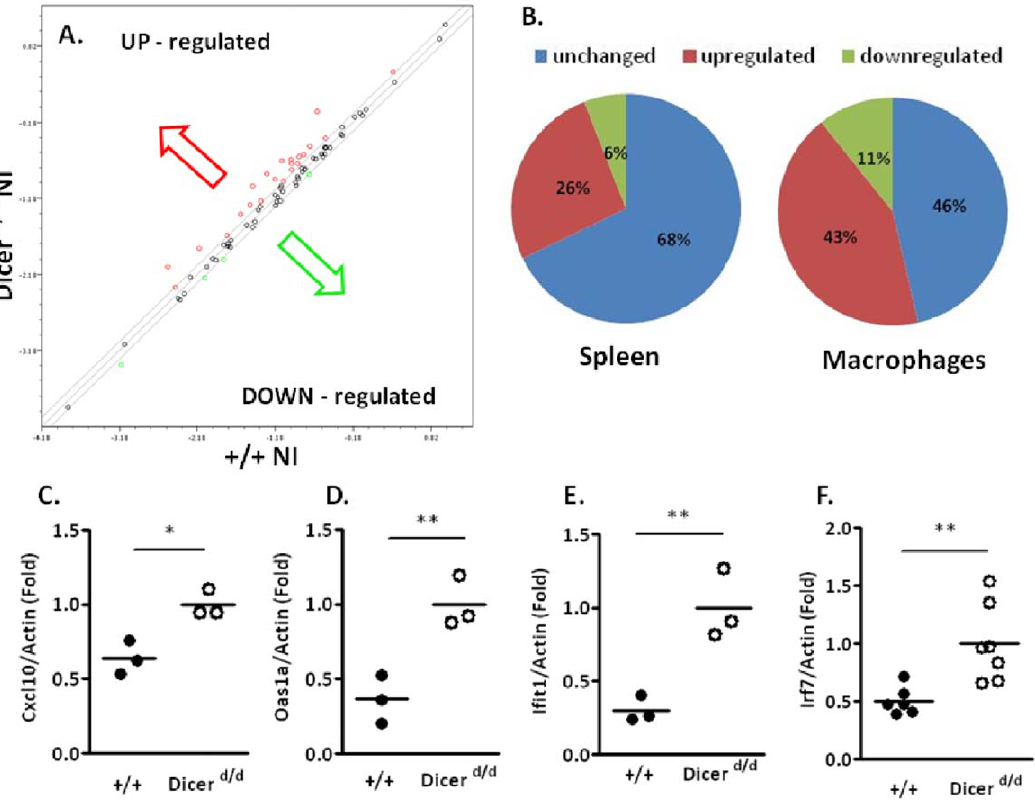
Figure 1. Dicer-deficient mice exhibit constitutive up-regulation of IFN-stimulated genes in splenocytes. A. Scatterplot illustrating macroarray data performed on mRNA from non-infected (NI) spleens harvested from control mice ( + / + ) or Dicer d/d mutants. Red dots indicate up- regulated genes in mutants, whereas green dots represent down-modulated genes. B. Repartition of up-regulated genes (red), down-regulated (green), or whose expression remains similar in Dicer d/d splenocytes and macrophages compared to controls (blue). C–F. qRT-PCR experiments on selected IFN-dependant genes performed on mRNA extracted from control ( + / + ) or mutant ( Dicer d/d ) spleens. doi:10.1371/journal.pone.0043744.g001 PLOS ONE |